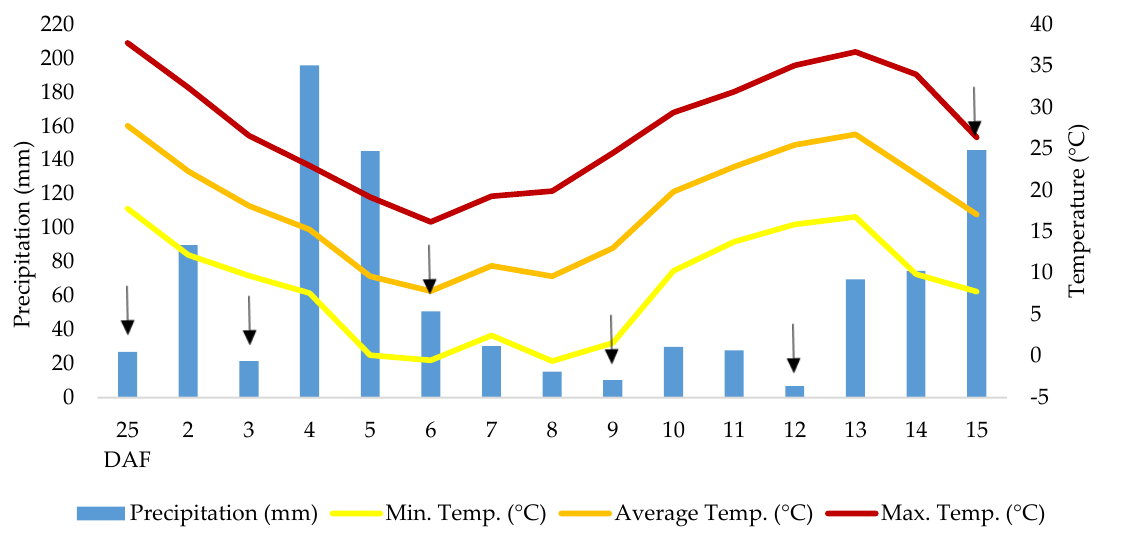
Figure 3. Monthly precipitation and air temperatures throughout the study period. Arrows point to the days and months when the sampling campaigns were performed. Numbers indicate days after fire (DAF) and months after fire (MAF).